Question: Give a one-sentence summary of this figure.
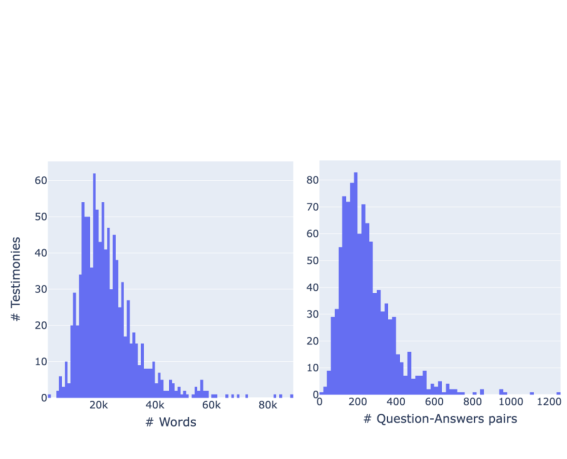
Answer: Testimonies number of words and number QA-pairs histogram.